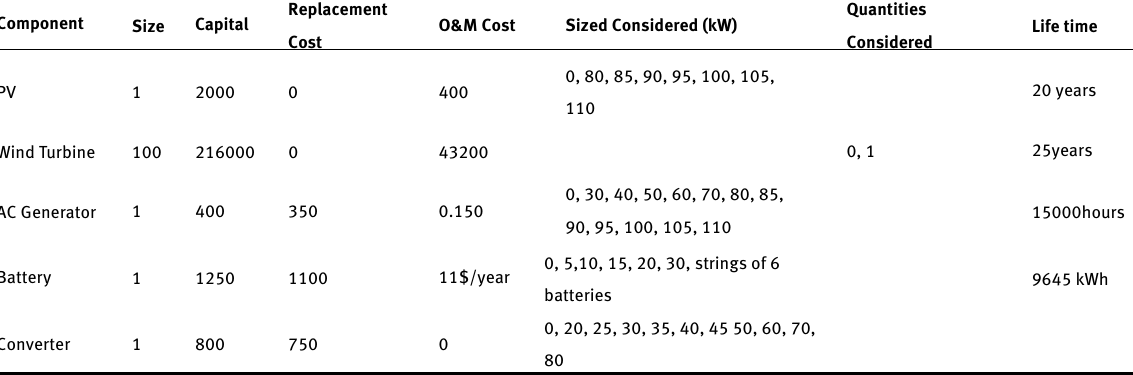
Table 3: System Sizing